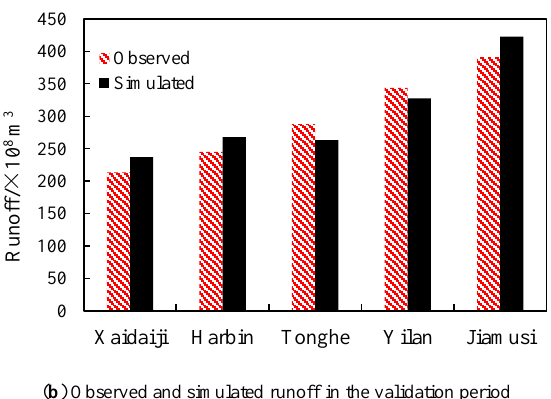
Figure 4. Observed and simulated runoff in the calibration and validation periods.